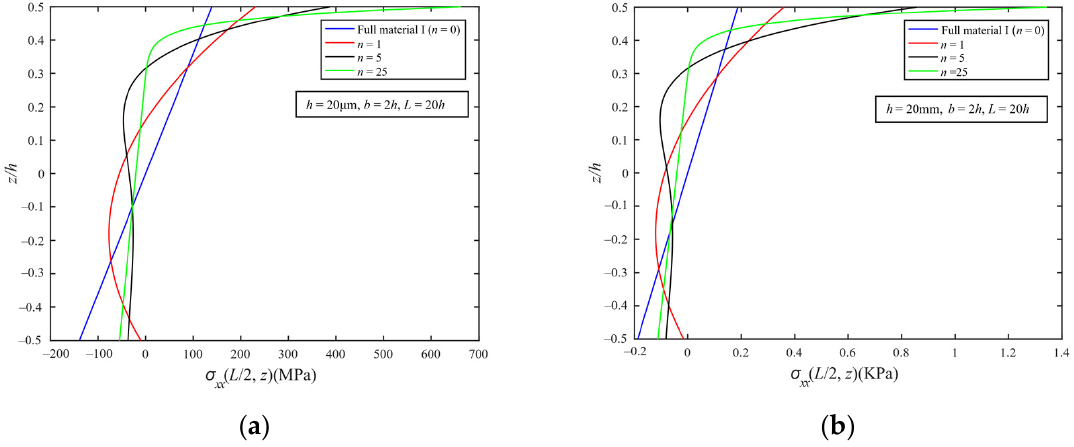
Figure 10. Axial normal stress of the current MEE-FGM beam through the thickness with ( a ) h = 20 μ m, ( b ) h = 20mm.